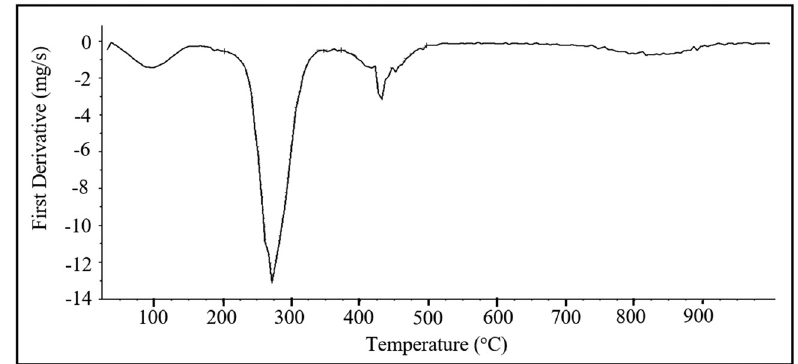
Figure 10: DTGA thermogram of reinforced PVA coating.